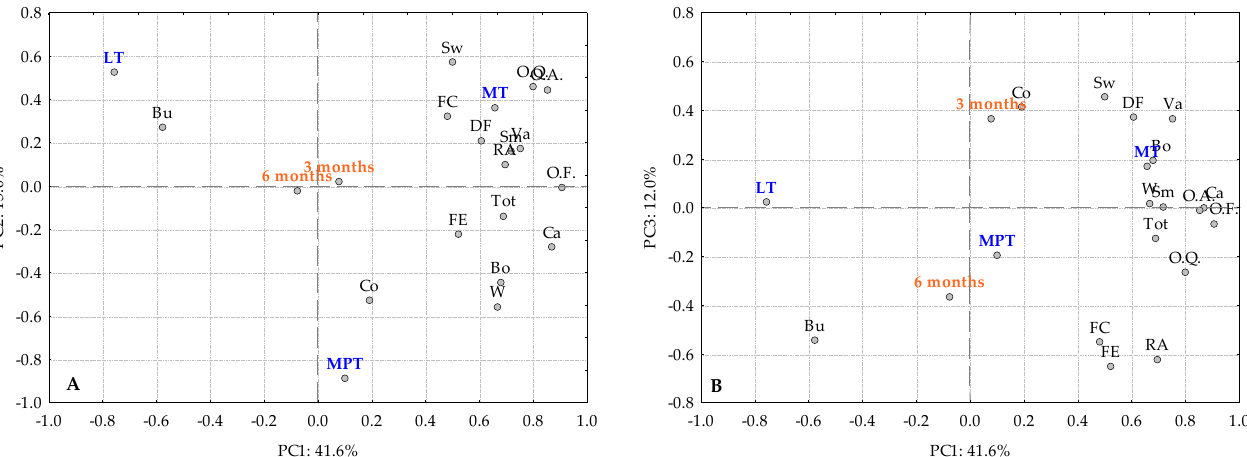
Figure 4. Principal component analysis of AUS aged with oak wood aged during three and six months for: ( A )—PC1 vs.